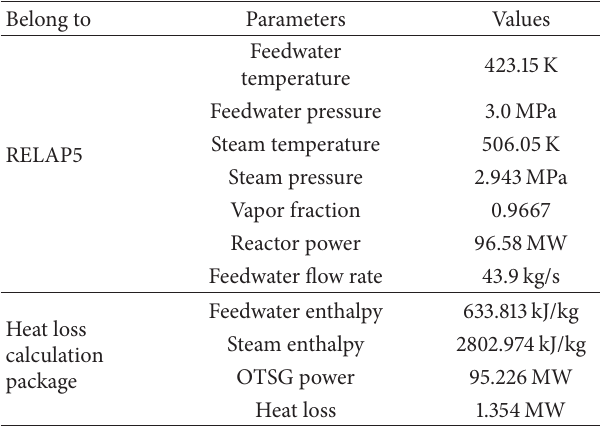
Table 3: Values of heat loss calculation.